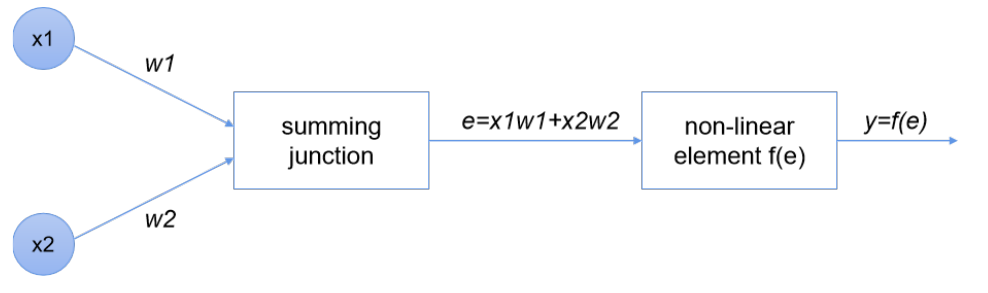
Figure 6. Structure diagram of the BP neural network. Figure 7. Neuron calculation method. Figure 7. Neuron calculation method.